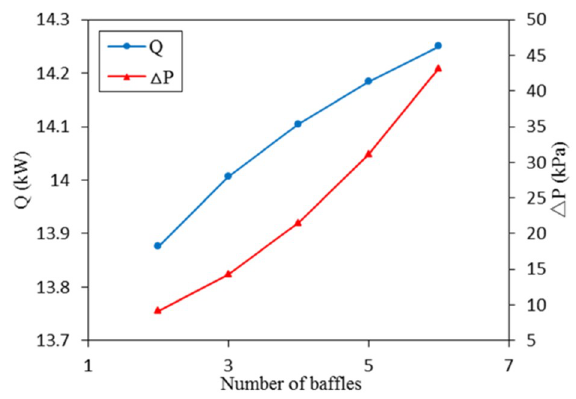
Figure 14. Heat transfer capacity and shell-side pressure drop separately versus number of baffles.